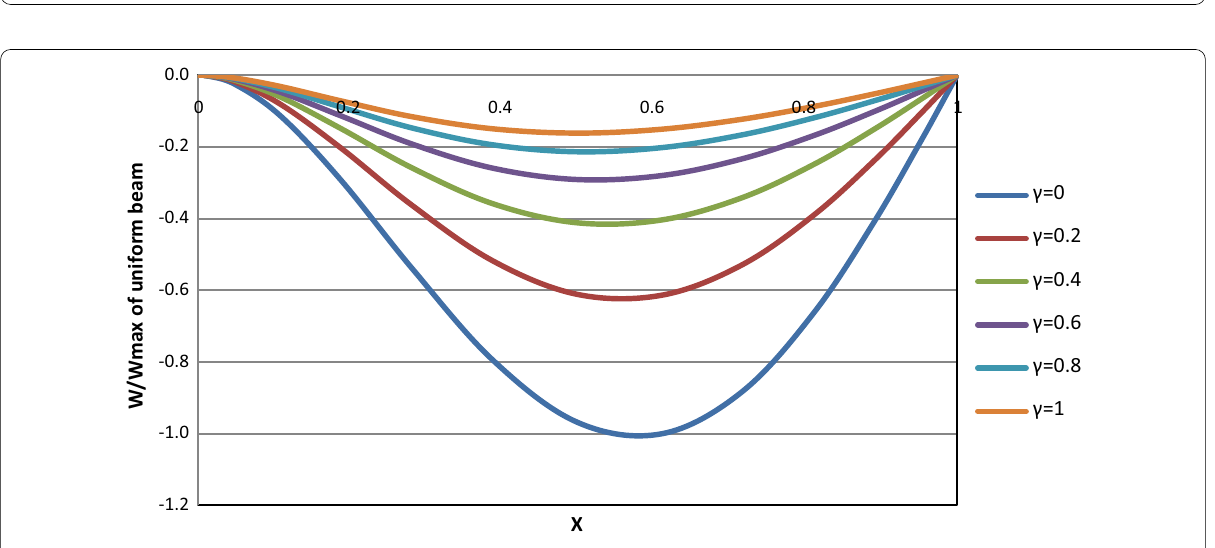
Fig. 3 Deflection of clamped–clamped non-prismatic beam